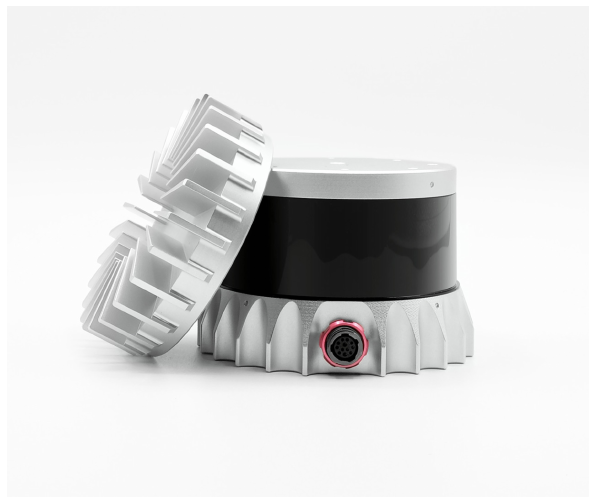
Figure 3. Ouster OSI-64 Sensor (Source: www.ouster.com)